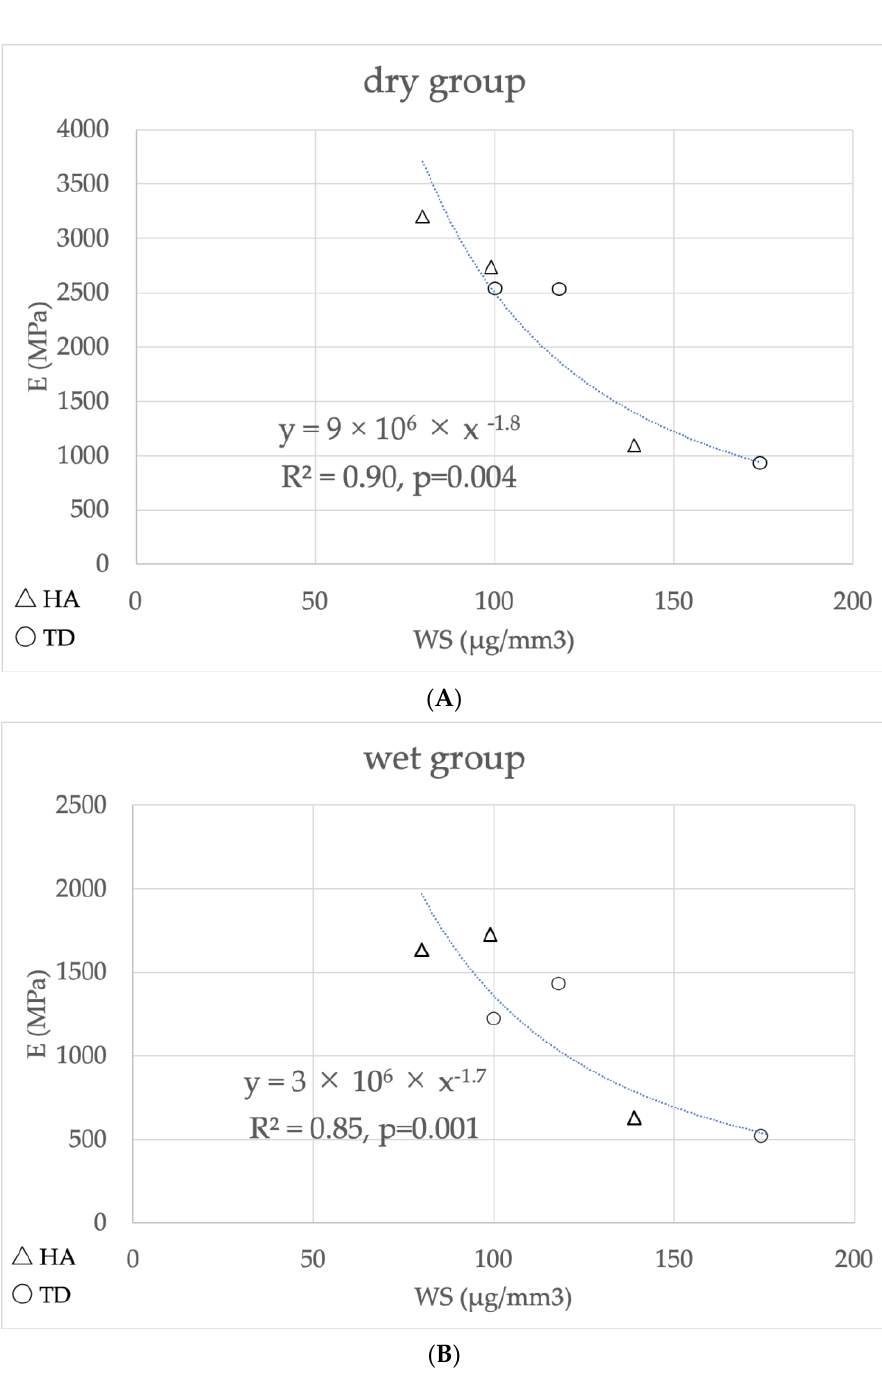
Figure 4. Regression analysis of the correlation between ( A ) E (dry group) and WS, ( B ) E (wet group) and WS.